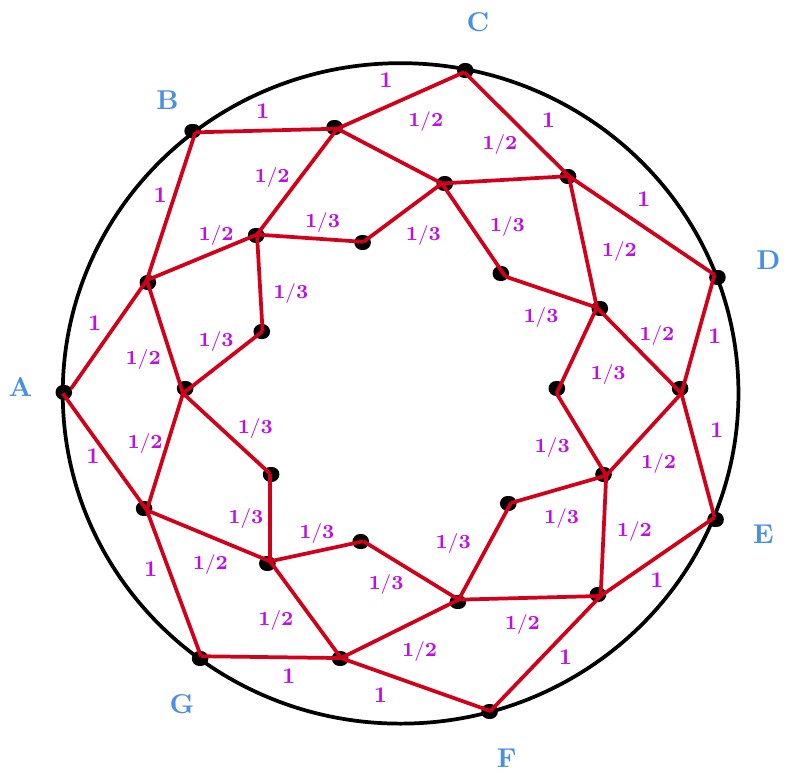
Figure 12 . The N = 7 diamondwork graph with harmonic edge